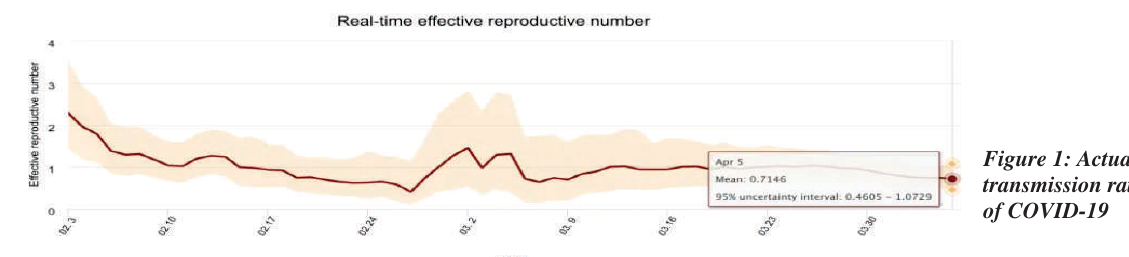
Figure 1: Actual transmission rates